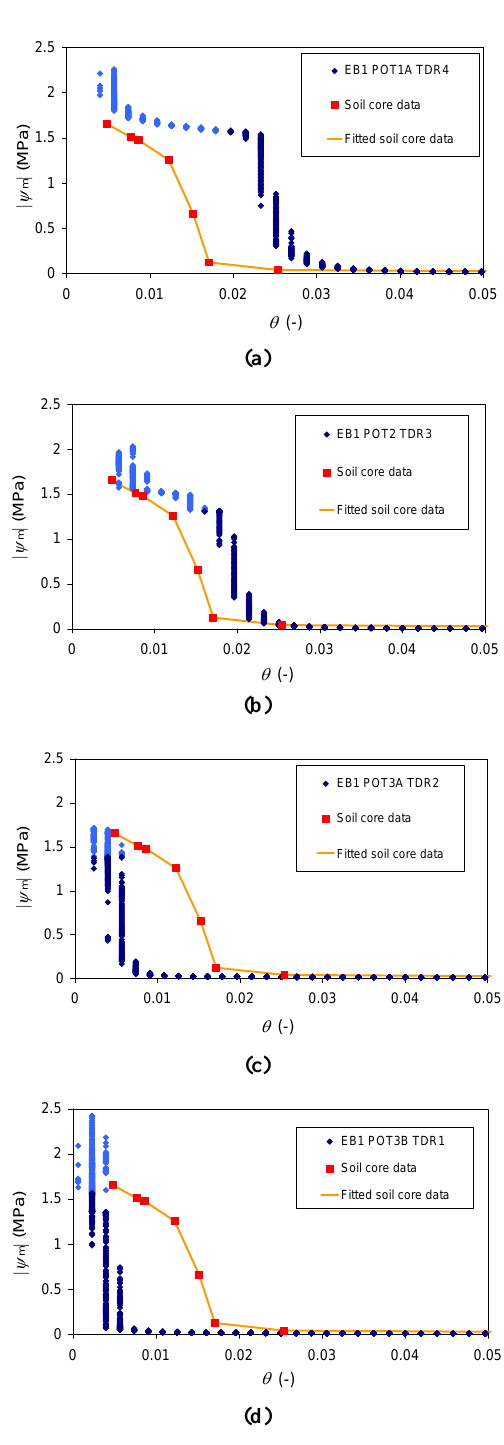
Fig. 9. Moisture retention curves (detail) of EB1 for the paired poly- mer tensiometers (POTs) and time domain reflectometers (TDR) to- gether with gravimetric data from soil cores, and fitted retention curve. The minus sign of the matric pressure values ( ψ m (MPa)) has been omitted. For complete curves see Fig.